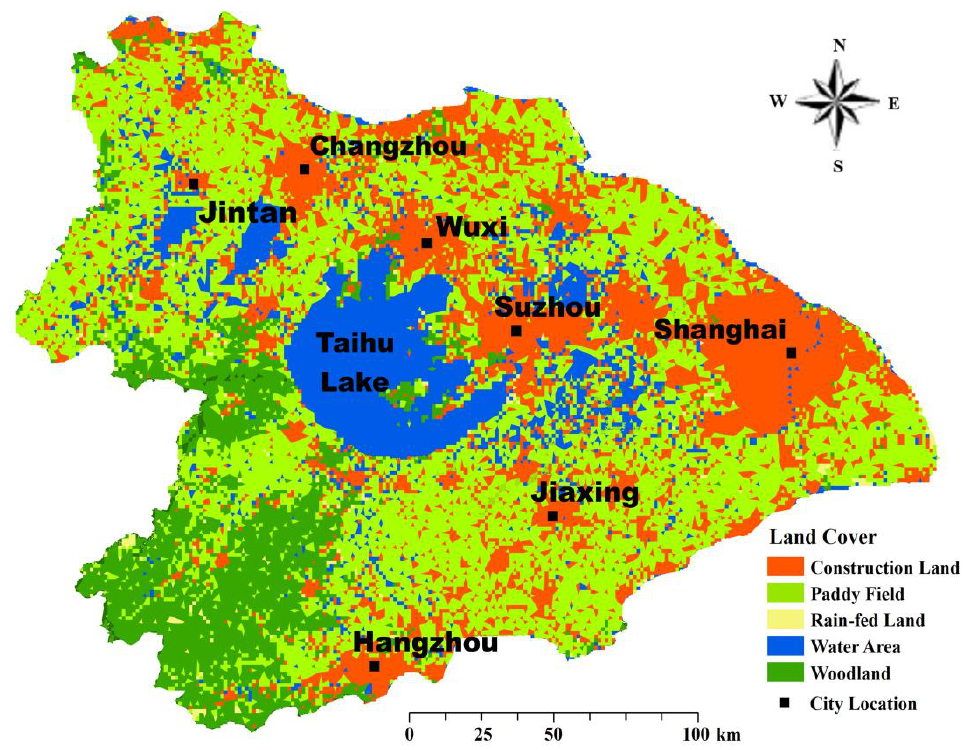
Figure 2. The digital land cover for the distributed-framework basin modeling system in Taihu Basin. In the DFBMS, the water body can be simulated as a storage node, generalized chan- nel, or lake. A larger water body (such as a large lake) can be easily extracted from the satellite picture and electronic map. However, it is hard to distinguish a small water body in the basin. The area of the generalized channel in the digital model is the size of the cross section. The channel area is estimated when the water surface elevation is set to 3 m. There are also 76 storage nodes in the simulation model of Taihu Basin. The total water area for the mesh is smaller than the actual water area. Four kinds of digital underlying surface areas are shown in Table 3, which agree with the survey results in Table 1. After we ob- tained the underlying surface information for each grid, the runoff on each surface was calculated based on the rainfall-runoff mechanism introduced in the second paper in the series.